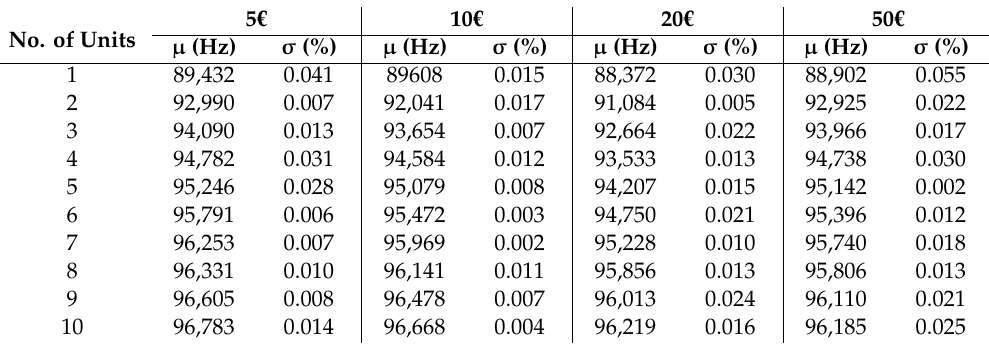
Table 3. Frequencies measured for each banknote